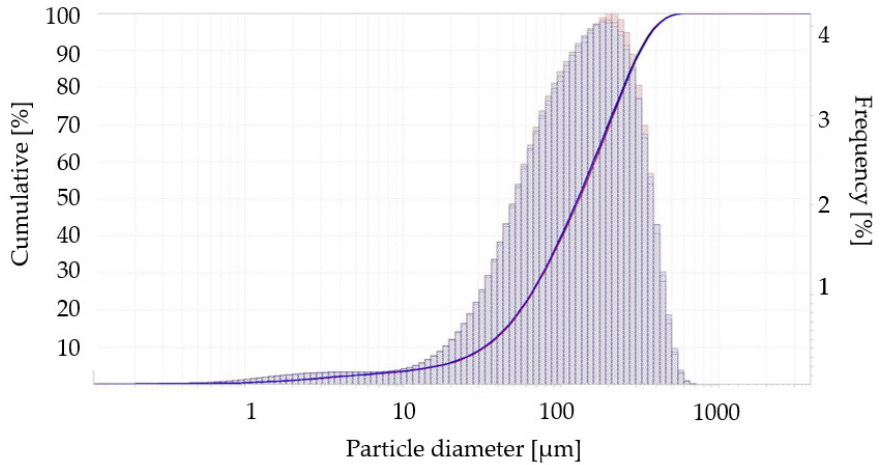
Figure 2. The frequency distribution and cumulative frequency of particle size distribution of sludge dust (measurement 2). Table 6. Results of the third particle size distribution analysis in terms of cumulative frequency.